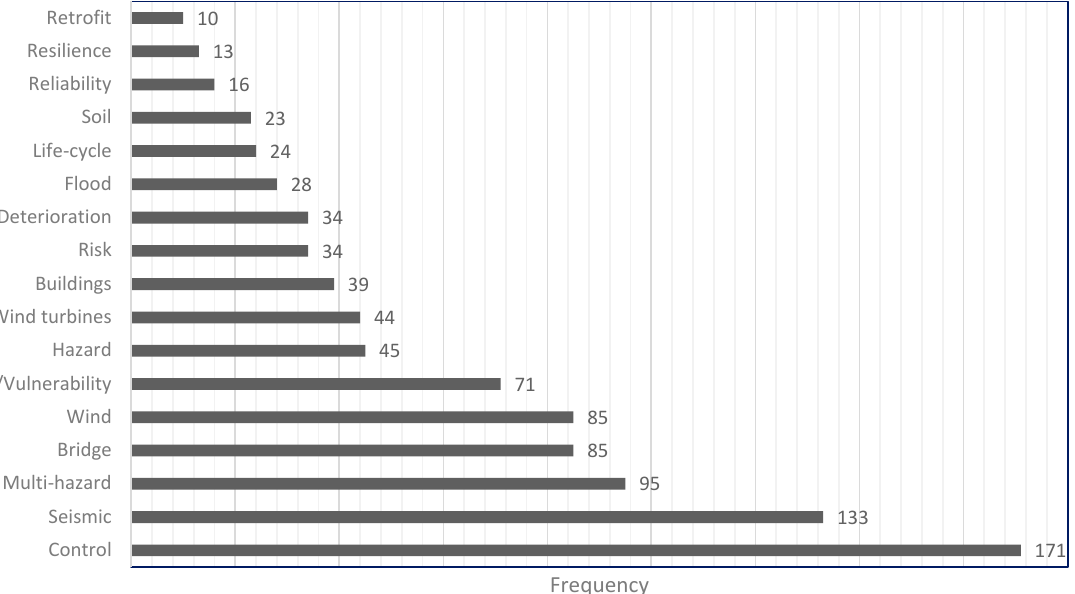
Figure 2. Frequency distribution of the most relevant themes extracted from reduced keywords.